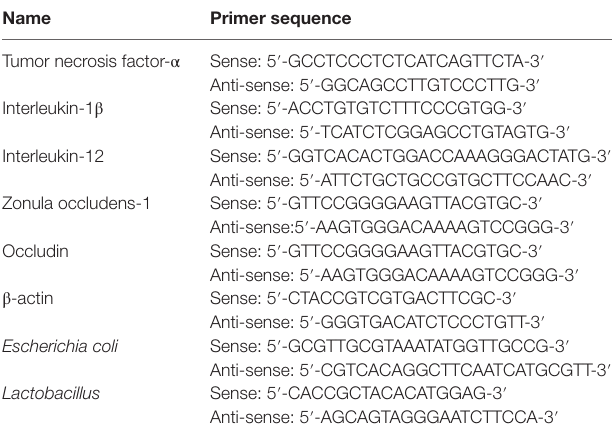
TaBle 1 | Oligonucleotide primers used for quantitative real-time Pcr.